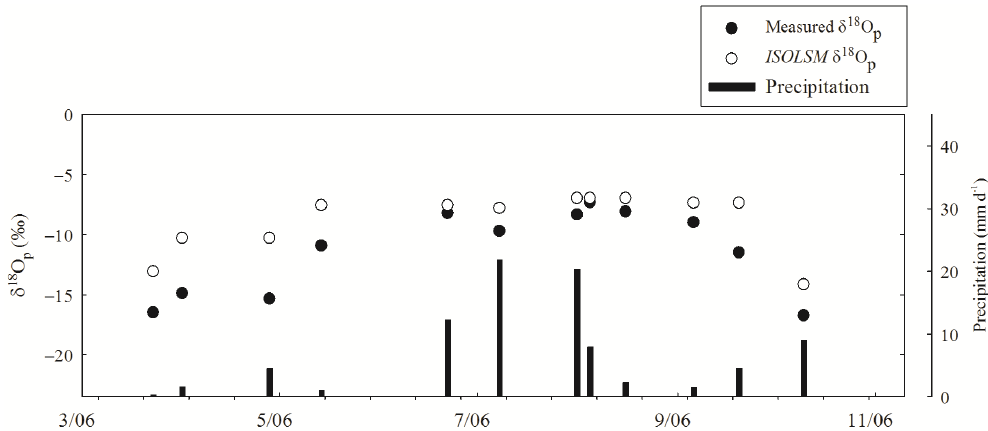
Fig. A7. Pulse precipitation events and associated δ 18 O of precipitation in 2006 for the time periods presented in this